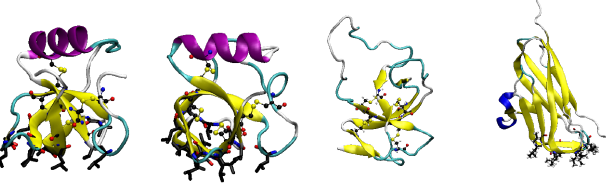
Figure 2. Structures of commonly studied hydrophobins. (Left to right) Class-II hydrophobins HFBII and HFBI, class-I hydrophobin EAS, and bacterial hydrophobin BslA. Figures generated using VMD [79] and PDB accession codes 1R2M, 2FZ6, 2FMC, and 4BHU, respectively. Residues in hydrophobic patches are